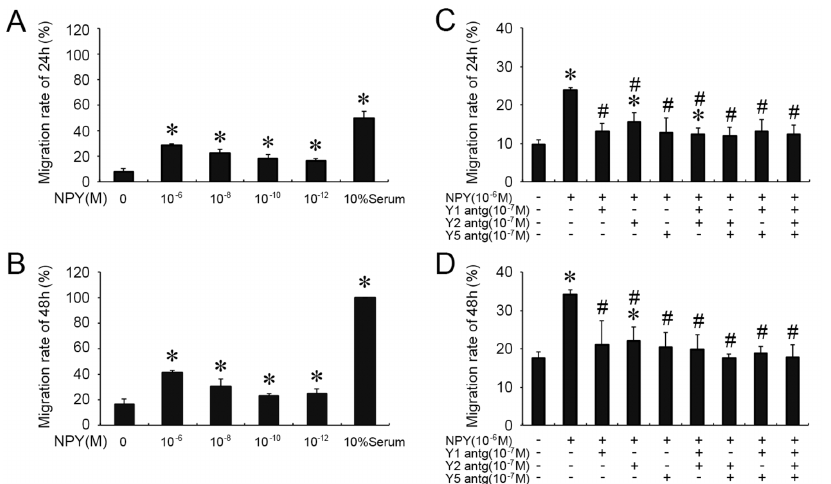
Fig 4. NPYs induced the migration of cultured VSMCs, and the NPY receptors were involved in this process. (A), (B) NPYs at different concentration treated for 24 hours and 48 hours induced the migration of cultured VSMCs ( n = 4). The migration rate of VSMCs is defined as the ratio of migrating distance, after 24 hours ’ treatment, to the initial distance scratched by sterile 200 μ l pipette tip. Shown values are the mean ± SD , * P < 0.05 v . s . the respective control; (C), (D) VSMCs were pre-incubated with single or combinational NPY receptor antagonists (NPY 1, 2 and 5 receptor antagonists), and then treated with 10 − 6 mol/L NPY for 24 hours and 48 hours ( n = 4). Shown values are the mean ± SD , * P < 0.05 v . s . respective the first column (0 mol/L NPY); # P < 0.05 f v . s . respective the second column (10 − 6 mol/L